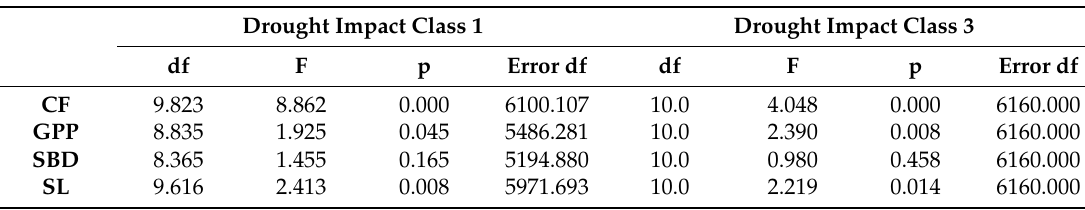
Table A2. Significance of differences in 2002–2012 annual forest phenology and green biomass production as indicated by repeated measure ANOVA models inspected separately for drought impact class 1 and 3 of the 4nNDII7 PC. Abbreviations correspond with Table